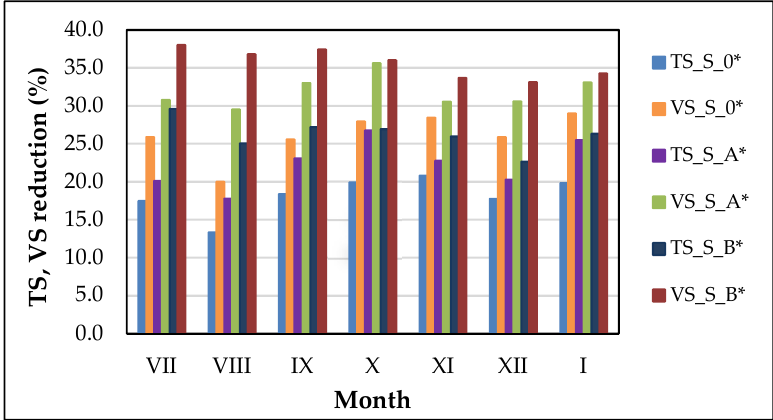
Figure 4. Total solids (TS) and volatile solids (VS) reduction after anaerobic digestion (AD) process.